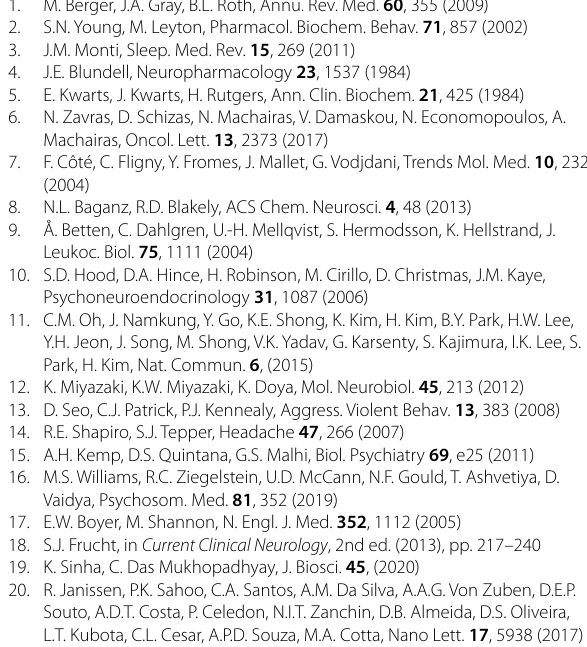
1 H-NMRof EDOT-Acid in DMSO. Figure S5 . Equation for 3 . Figure S4 . factor calculation. Figure S6 . Table of comparing various sensor platforms forthe detection of serotonin. FigureS7 . Real-time measurement of sero- tonin in the CSF solution with interferentmolecules. Acknowledgements Not